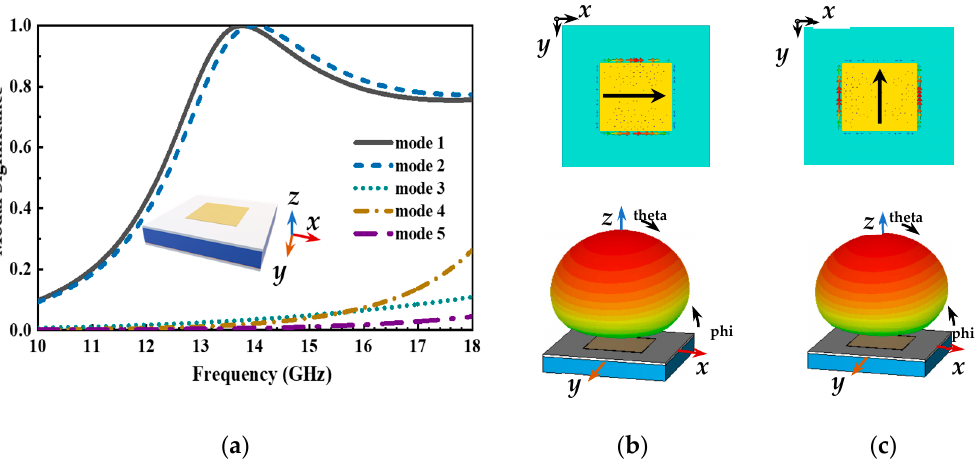
Figure 9. Modal behaviors of the top substrate, radiation patch, and honeycomb equivalent layer, ( a ) modal significance, ( b ) the modal current and far-field radiation pattern of mode 1, and ( c ) the modal current and far-field radiation pattern of mode 2.